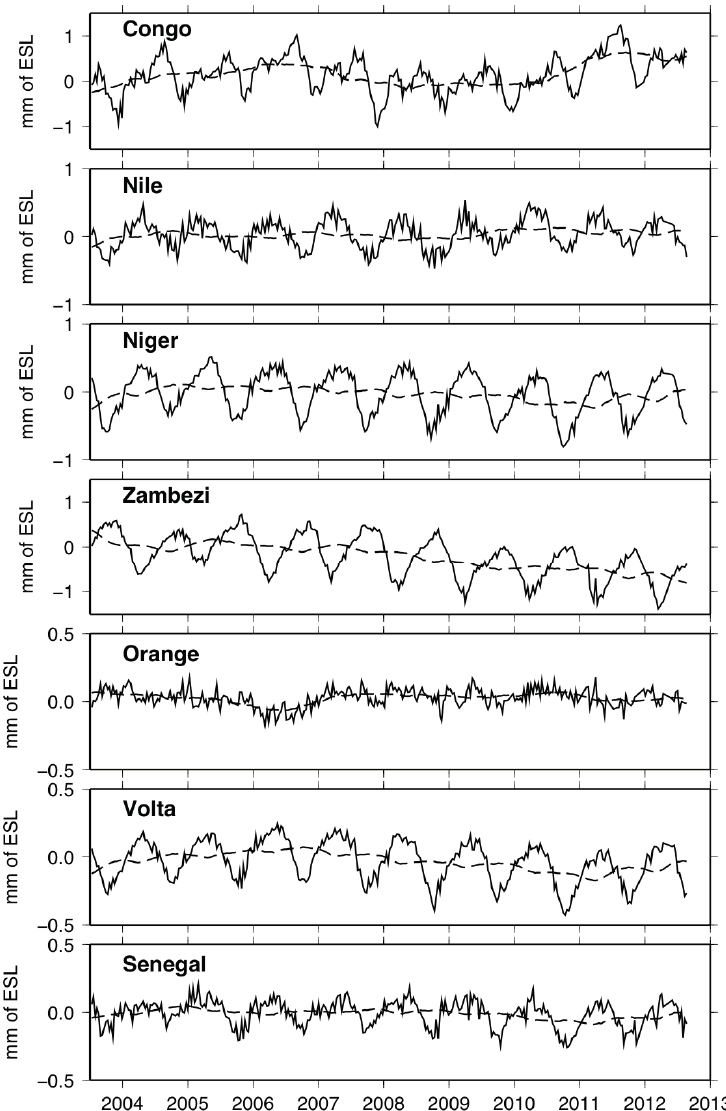
Figure 10. Time series of equivalent sea level (ESL) for the chosen main African river basins (solid line) and the corresponding 13-month low pass filtered profiles (dashed line).